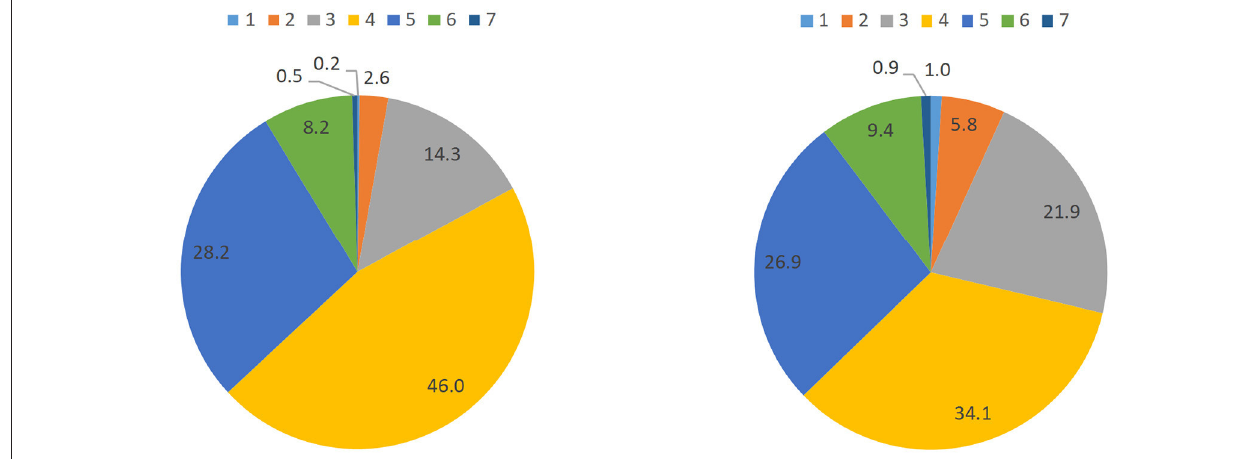
FIGURE 1 | Distribution of ICH in centenarians and oldest-old.